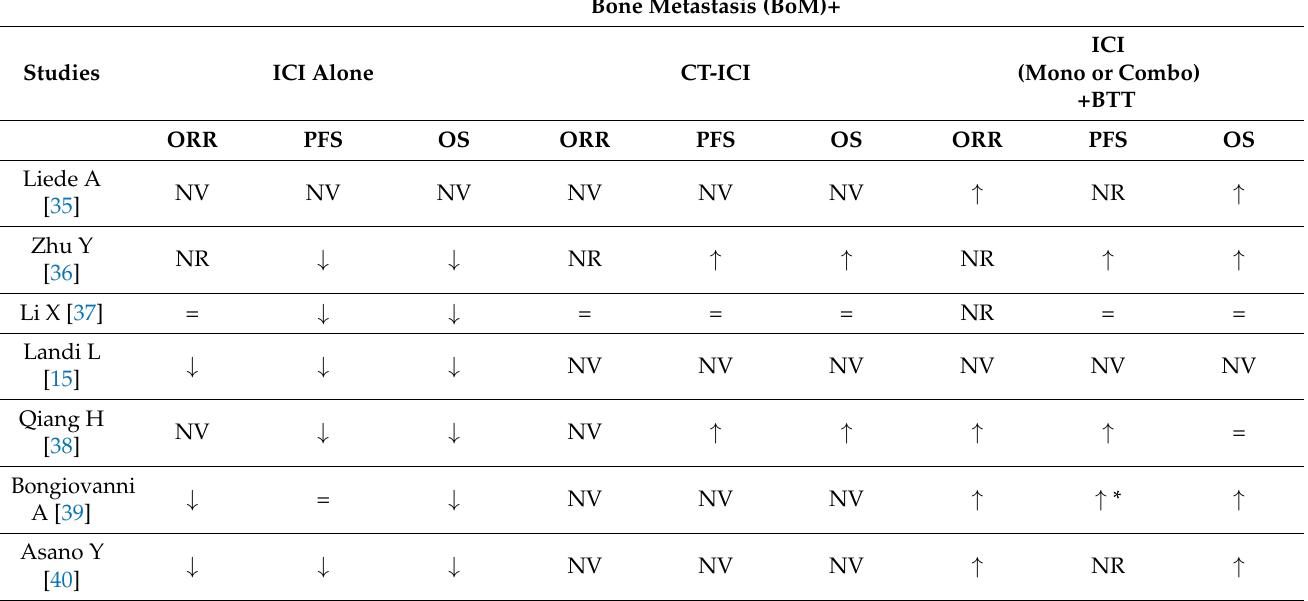
Table 1. The impact of ICI alone, in combination with chemotherapy (CT-ICI), or bone targeted therapy (BTT), according to different studies. ORR: overall response rate; PFS: progression free survival; OS: overall survival; ↑ increased; ↓ decreased; NV: not evaluable; NR: non reported; * only in patients treated with